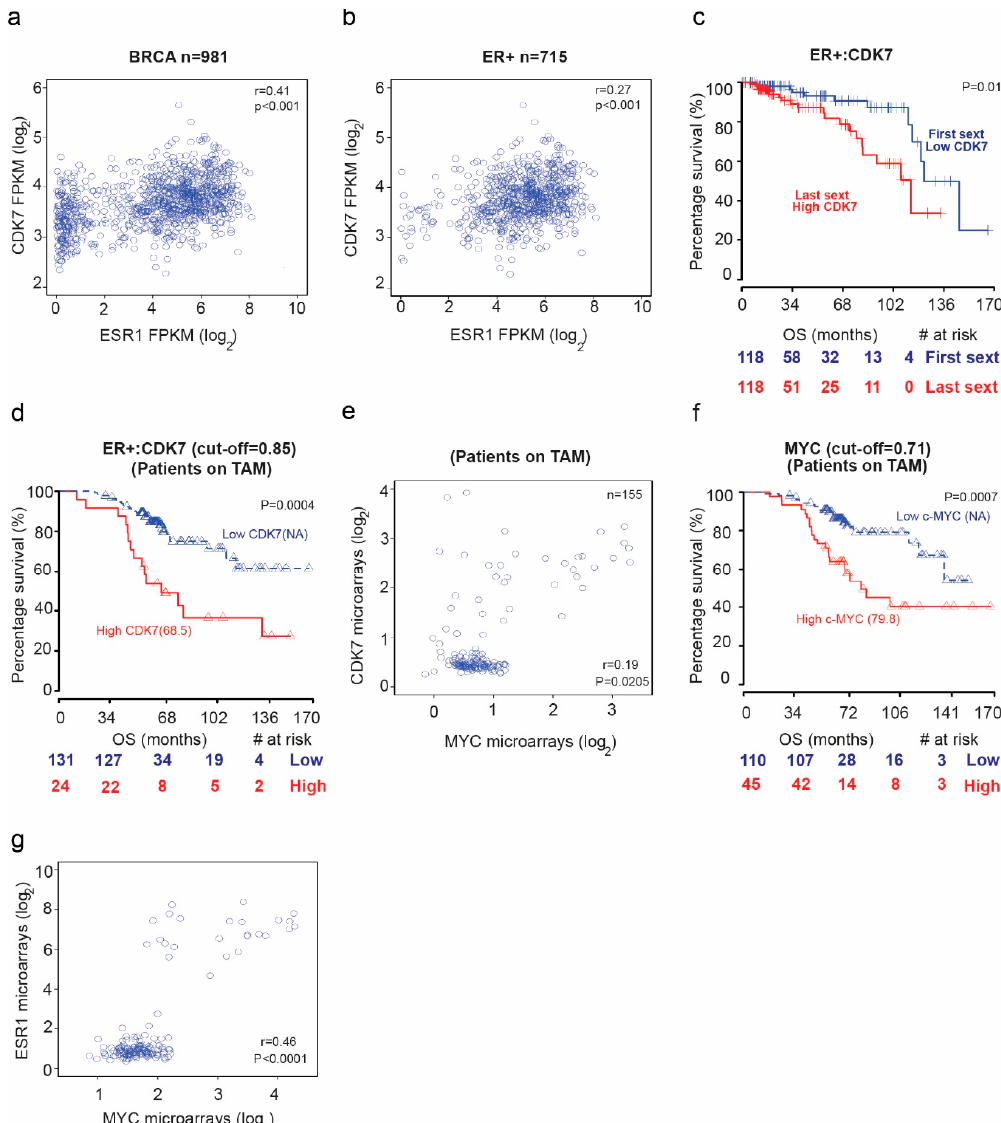
Figure 1. The relationship between cyclin dependent kinase (CDK7) expression and survival in breast cancer patients. Scatter plots of the Spearman rank-order correlation between ( a ) CDK7 and estrogen receptor alpha or 1 (ESR1) expression in 981 patients with breast cancer and ( b ) 715 patients with ER+ breast cancer. Data are from TCGA samples (RNASEqv2 data type). ( c ) Kaplan–Meier curves comparing overall survival (OS) in patients with ER+ breast cancer stratified by CDK7 expression level. ( d ) Kaplan–Meier curves comparing OS in patients with ER+ breast cancer receiving tamoxifen (TAM) by CDK7 expression level. ( e ) Scatter plot showing correlation between CDK7 and MYC expression in breast cancer patients receiving tamoxifen. ( f ) Kaplan–Meier curves comparing OS in breast cancer patients receiving tamoxifen by MYC expression level. ( g ) Scatter plot showing the correlation between MYC and ESR1 expression in breast cancer patients receiving tamoxifen.